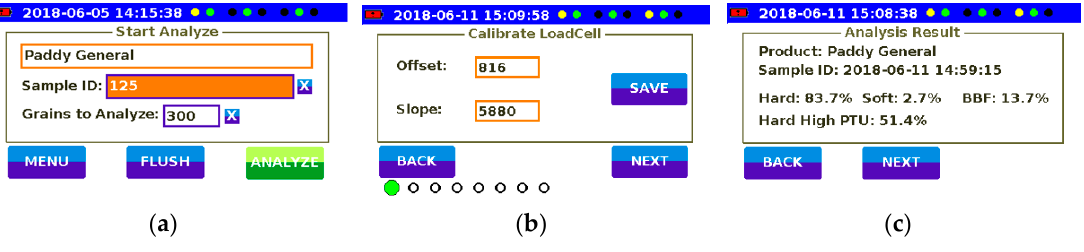
Figure 2. Touchscreen with selectable menus and displays. ( a ) Settings to define before analysis; ( b ) Settings to calibrate the load cell; ( c ) The results.